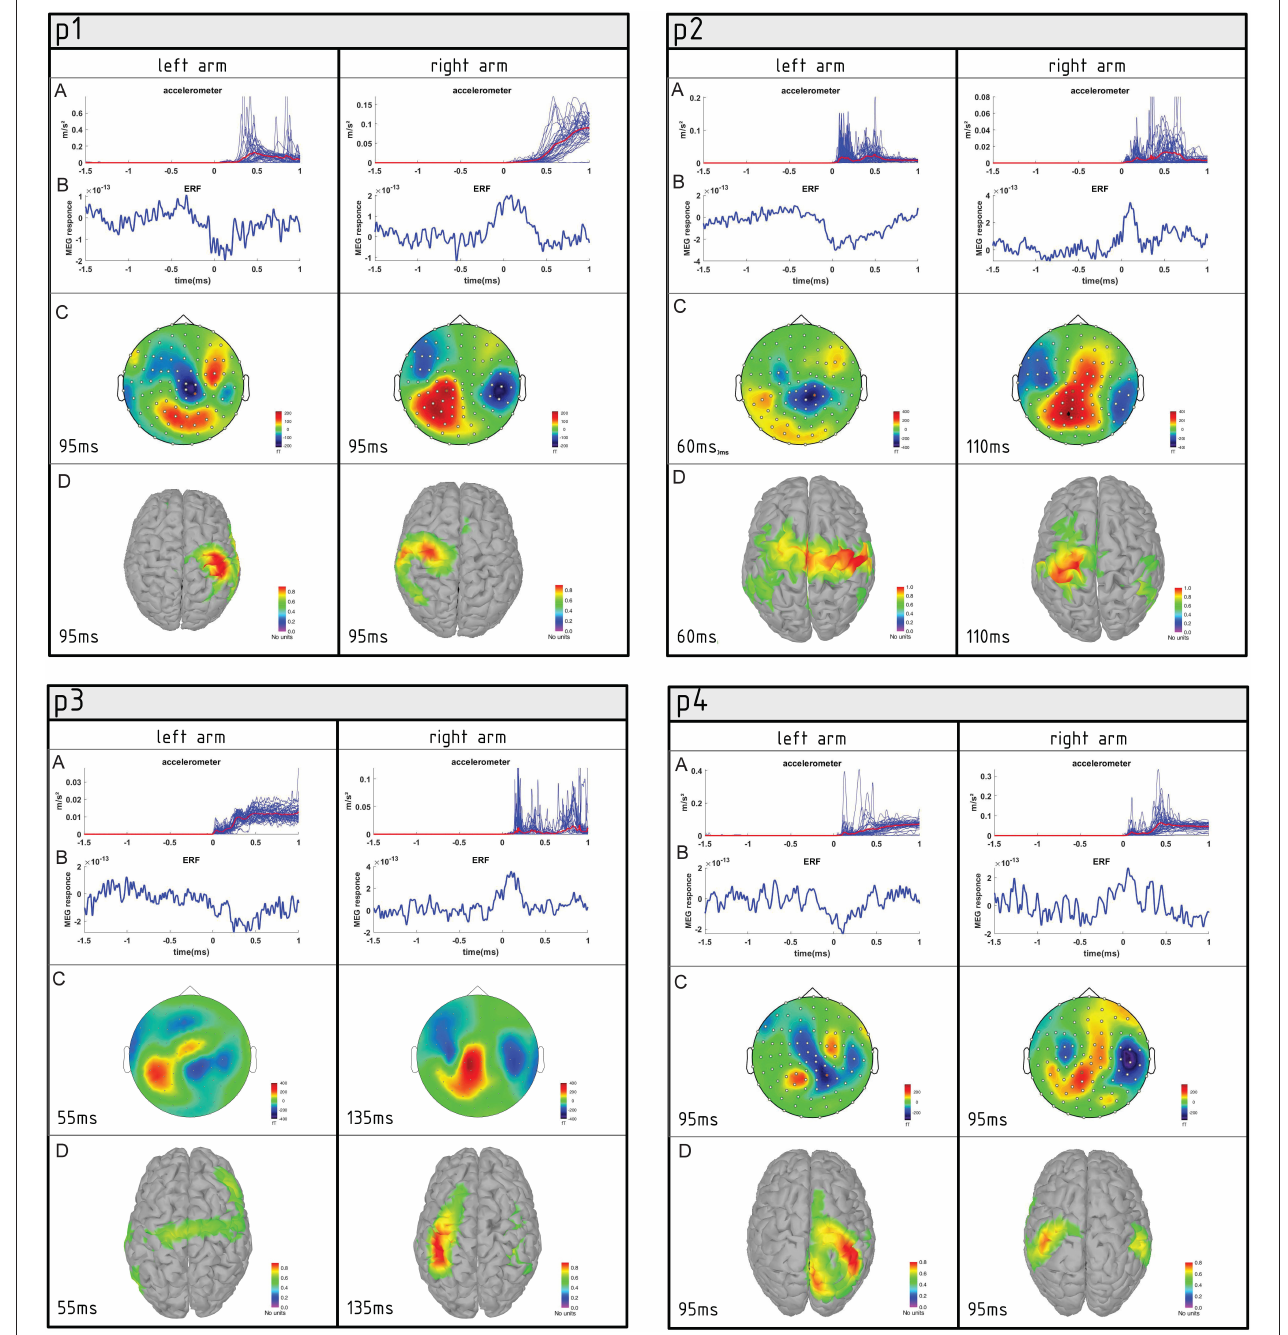
FIGURE 2 | Summary of movement-associated activity in four AMC patients (P1, P2, P3, and P4) performing semi-self-paced elbow flexion. (A) Plot of individual accelerometer power trials overlaid for the left and right elbows. (B) Averaged event-related fields (ERFs) at the representative channel. (C) Topographies of averaged ERFs at maximum peak latency. Positive values indicate magnetic flux exiting the head (red colors) and negative flux entering the head (blue colors). (D) Source reconstruction of ERFs. Neural activity is superimposed on the individual cortex model.